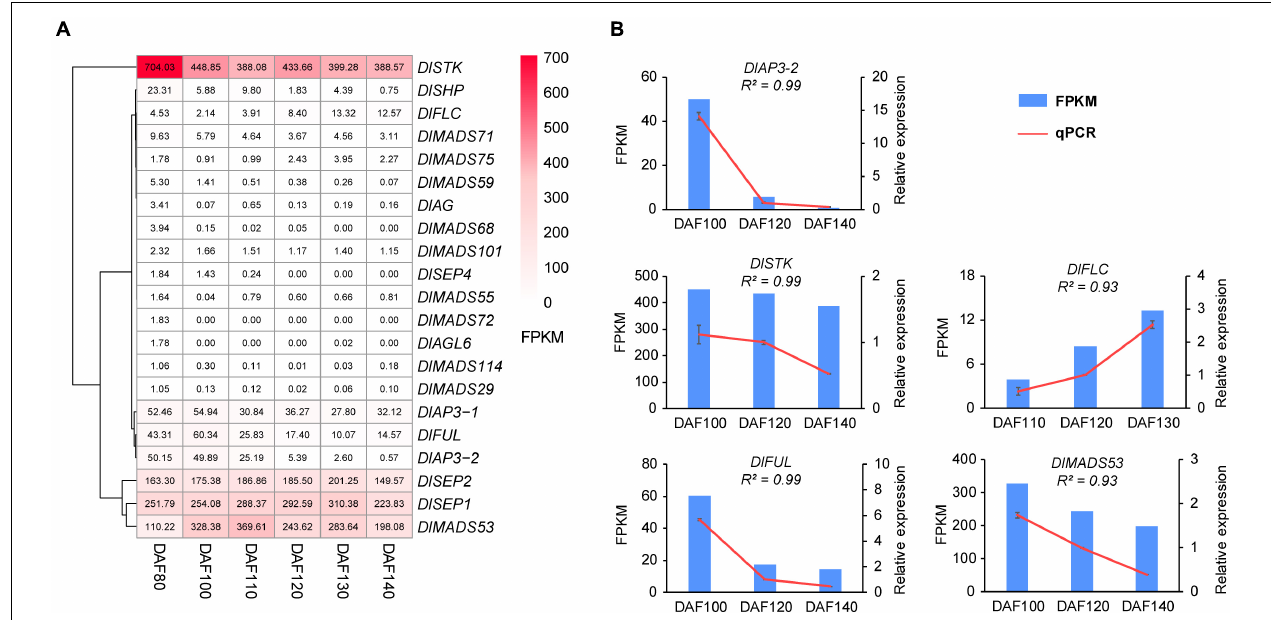
FIGURE 9 | The expression pattern of differentially expressed DlMADS during the fruit development stage. (A) Heat maps based on FPKM for differentially expressed DlMADS at three fruit developmental stages (80 ∼ 140 days after flowering). (B) Detection of five differentially expressed DlMADS at three selected stages by using qRT-PCR. The bar and line graphs are derived from RNA-seq and qRT-PCR data,